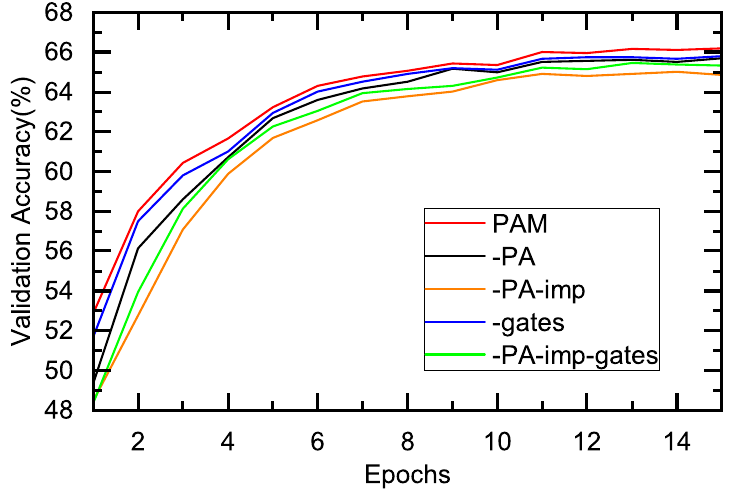
Figure 5. Validation accuracy versus epochs for the proposed VQA model.